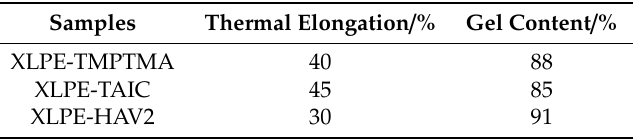
Table 1. Thermal elongation and gel